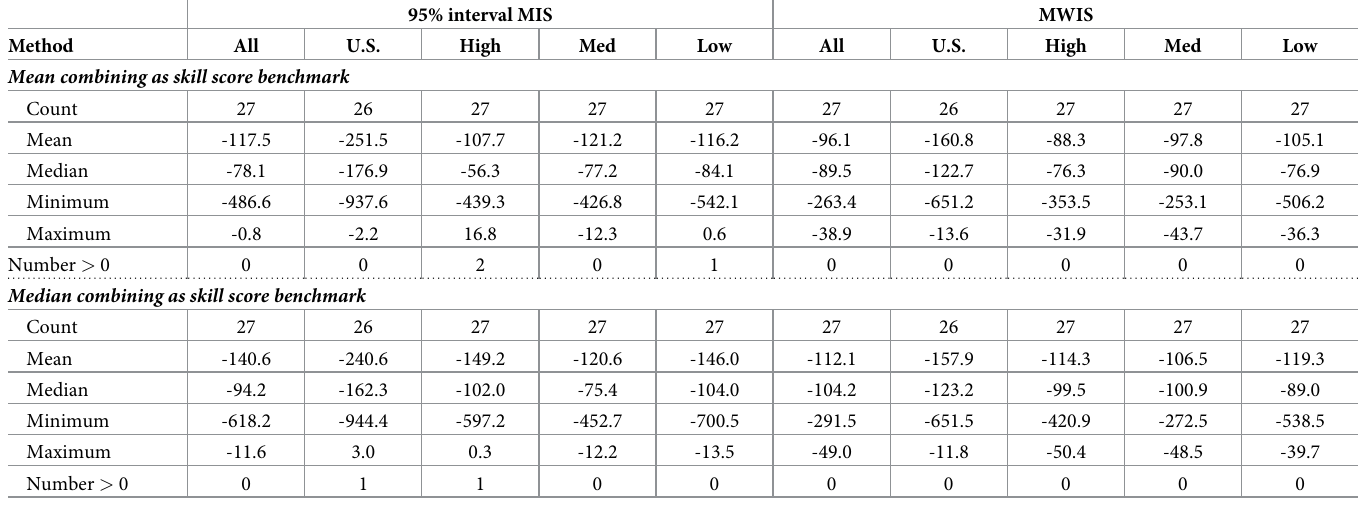
Table 6. For incident mortality, summary statistics of skill scores for individual